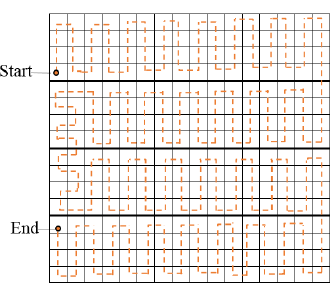
Fig. 10. space filling curve for layout of problem 2